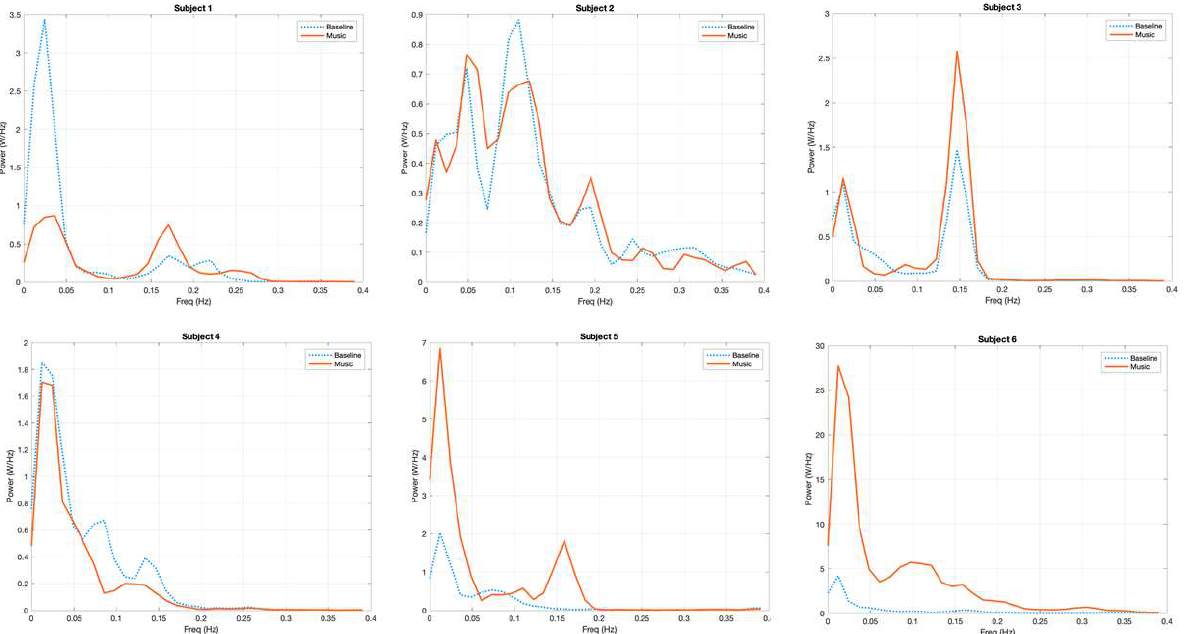
Figure 5. Power (W/Hz) spectrum analysis of O2Hb fNIRS signal of each subject for the right hemisphere during the first baseline (blue, dashed curve) and the first music block (red, solid curve). The y -axis expresses the values of power (W/Hz); the x -axis shows the frequencies (Hz). Note that the values of power are variable for every subject due to different light conduction properties of the skin (e.g., depending on pigmentation and dryness) and optode adhesion.